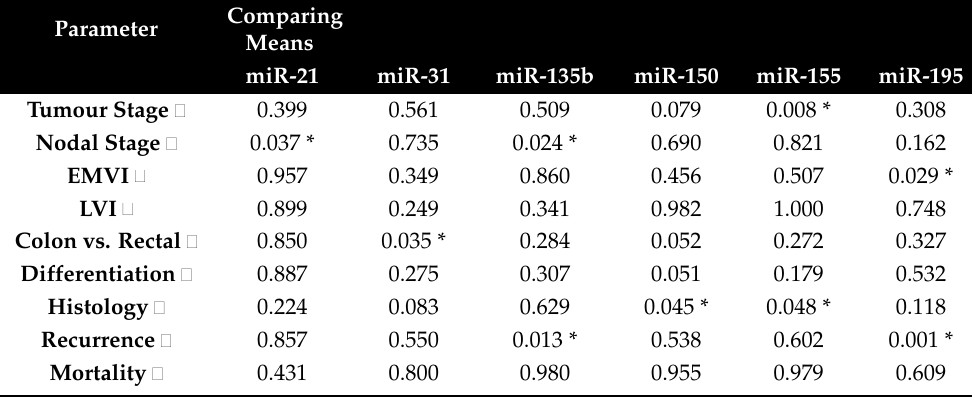
Table 3. Correlation of miRNA expression profiled with clinicopathological, recurrence, and survival data.